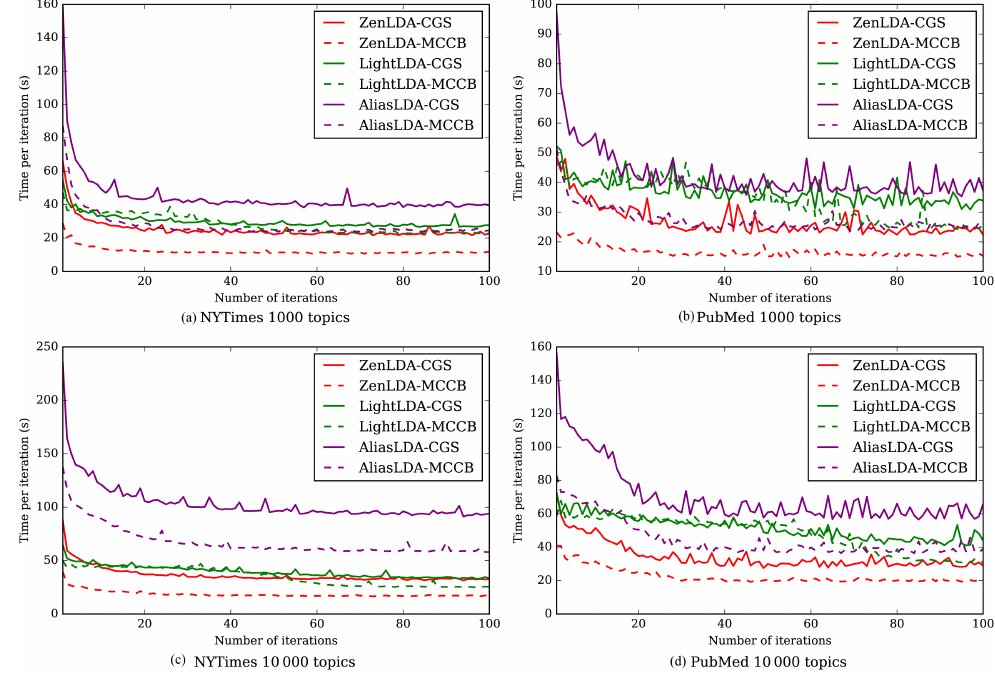
Fig. 7 Time cost comparison between CGS and